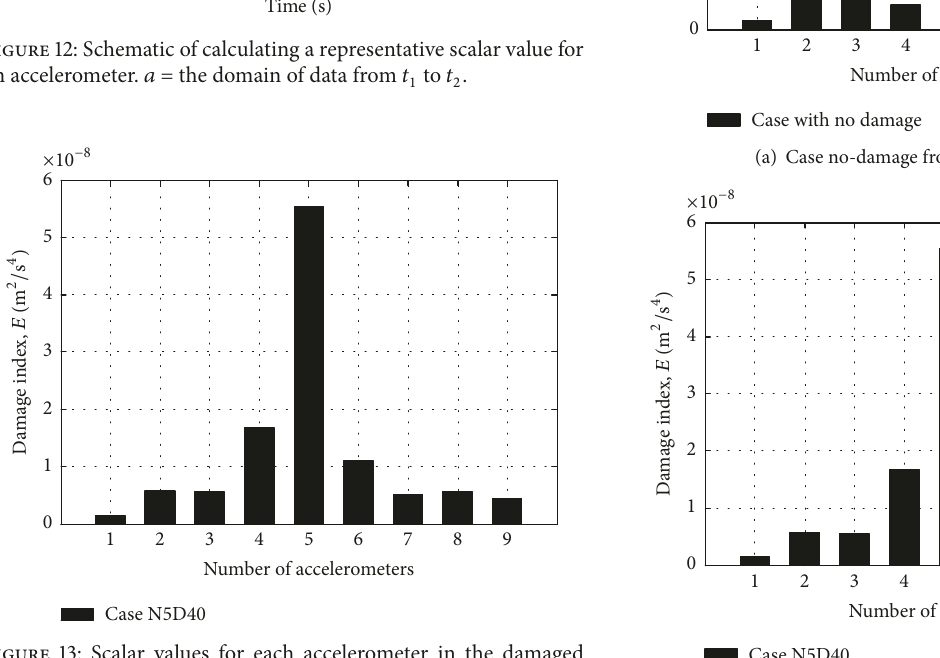
Figure 13: Scalar values for each accelerometer in the damaged beam (N5D40) (velocity = 0.3 m/s).